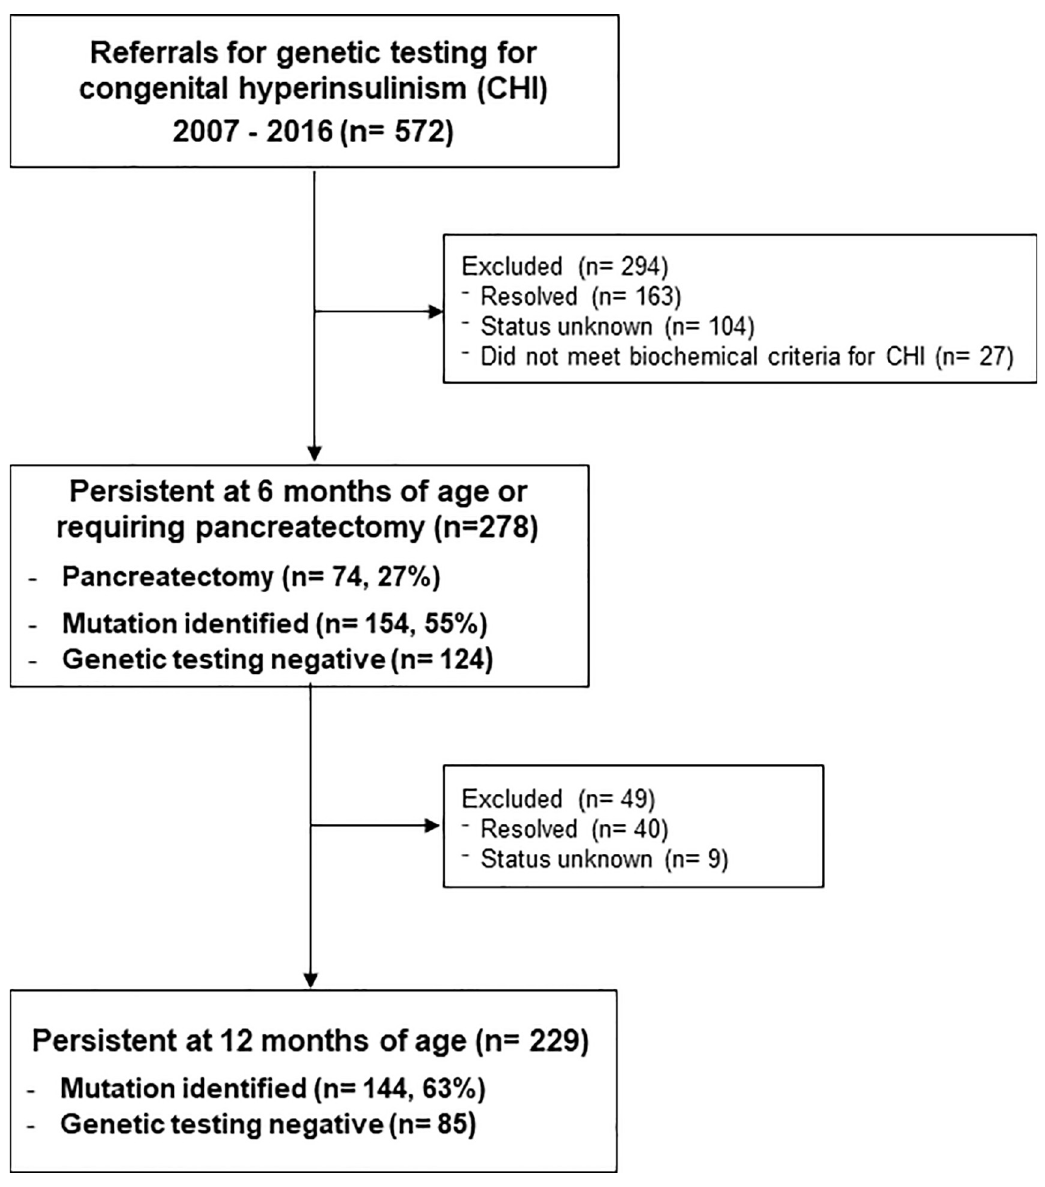
Fig 1. Flow diagram showing the outcomes of referrals for genetic testing for congenital hyperinsulinism.